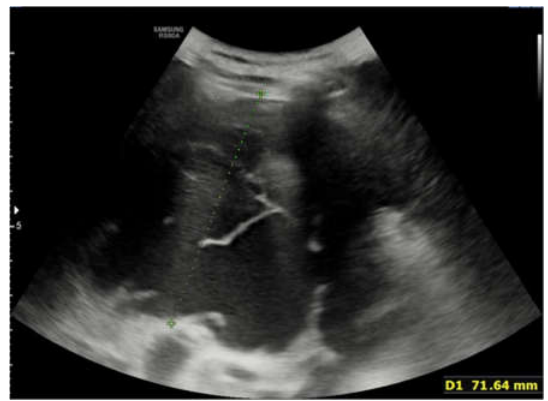
Figure 4. Lung ultrasound performed on the second day of stay, after the worsening of the clinical condition of the patient. The ultrasound showed the presence of large pleural effusion in the right hemithorax.